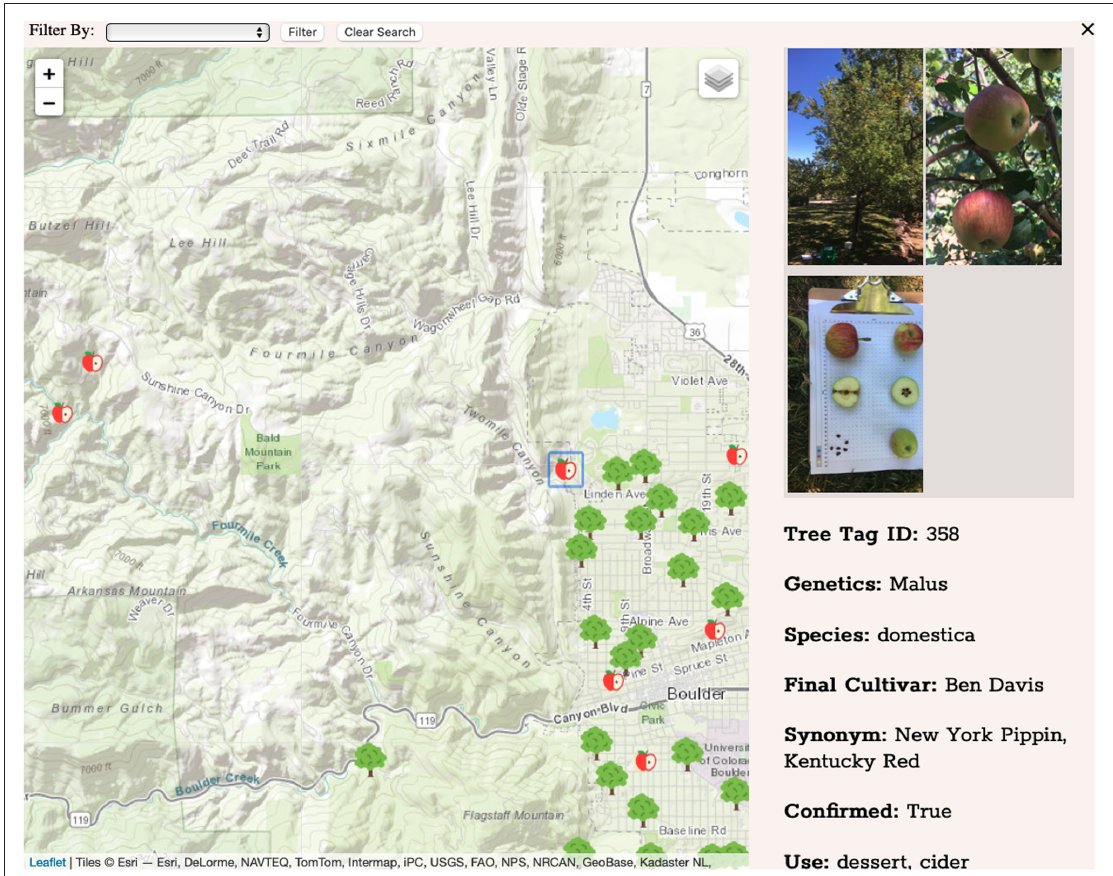
Figure 1 Interactive map display featuring an example tree. The apple icon shows the tree location on the map. Tree icons represent multiple entries in close proximity and will split into apple icons upon zooming in